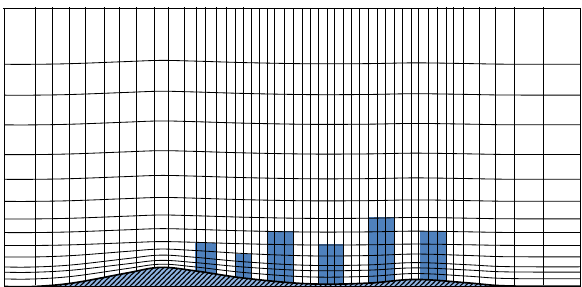
Figure 1. Vertical cross section to illustrate the MITRAS grid in the terrain-following coordinate system (not to scale). The blue blocks denote buildings. Not all grid cells are